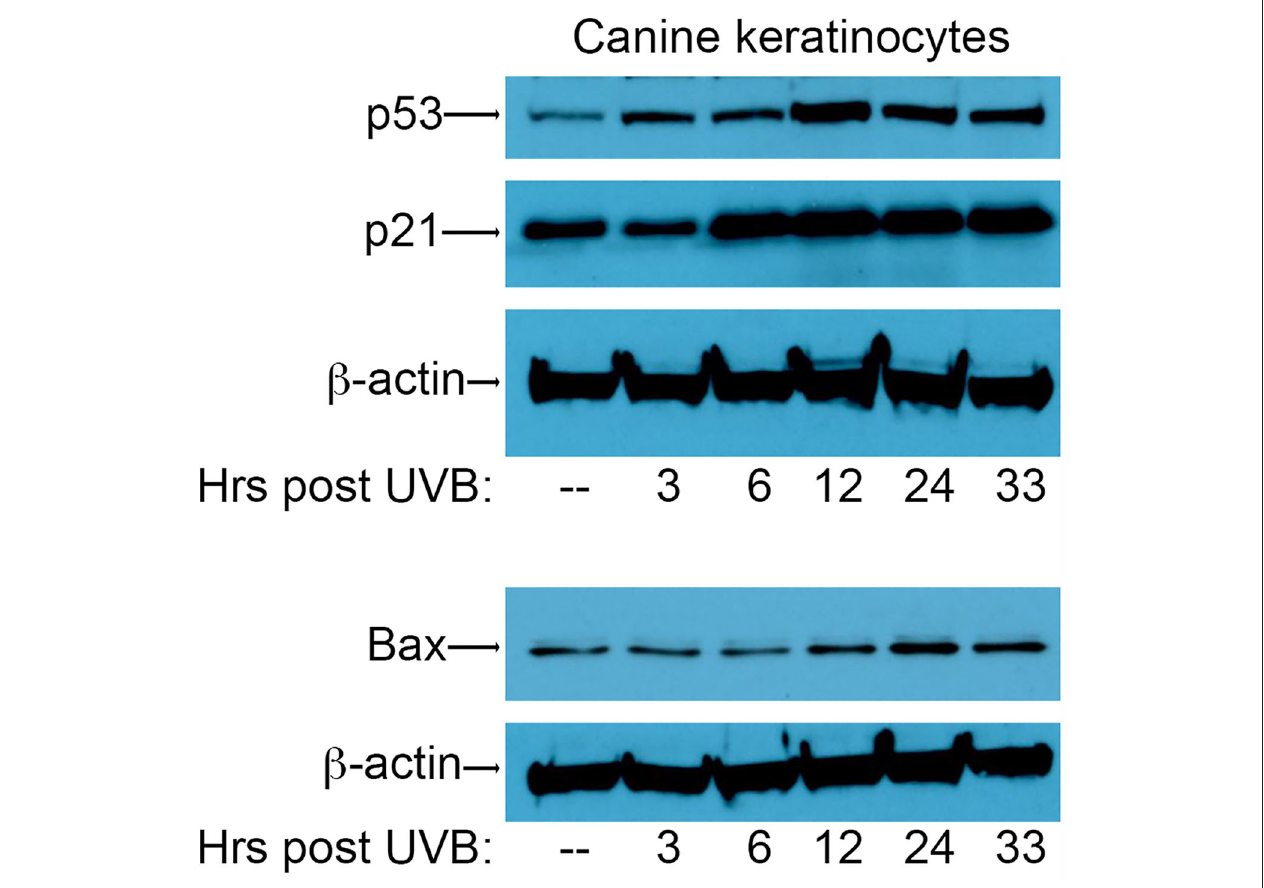
FIGURE 1 | Upregulation of p53 and p53-regulated genes p21 and Bax in canine keratinocytes in response to exposure to ultraviolet B (UVB) light. Normal canine keratinocytes were exposed to UVB (10 mJ/cm 2 ) and cell lysates collected at different times (hours) post-irradiation. Proteins were separated by SDS-PAGE and analyzed by immunoblotting with antibodies directed against p53, p21, and Bax. β -actin was used a loading control. One representative experiment of three is shown.